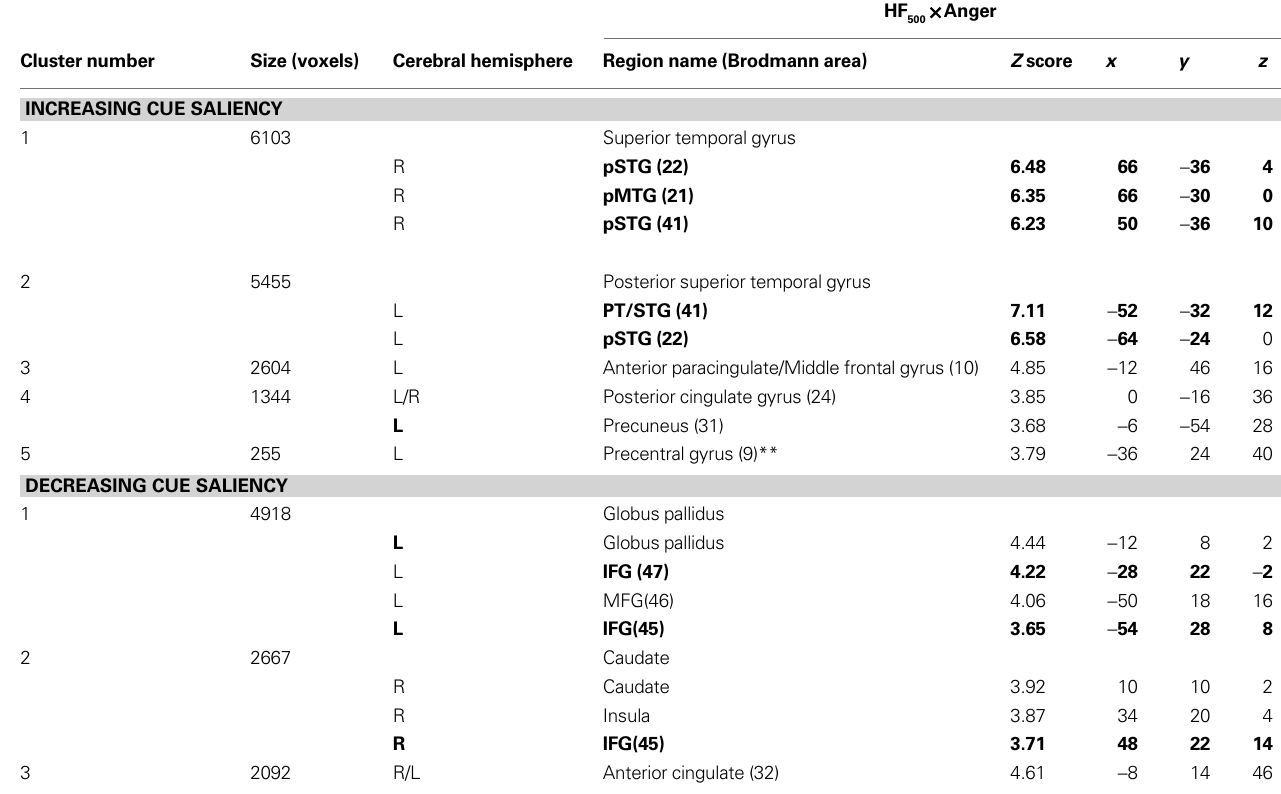
Table 4 | Mean cluster location and local maxima of BOLD signal change for Anger × cue saliency